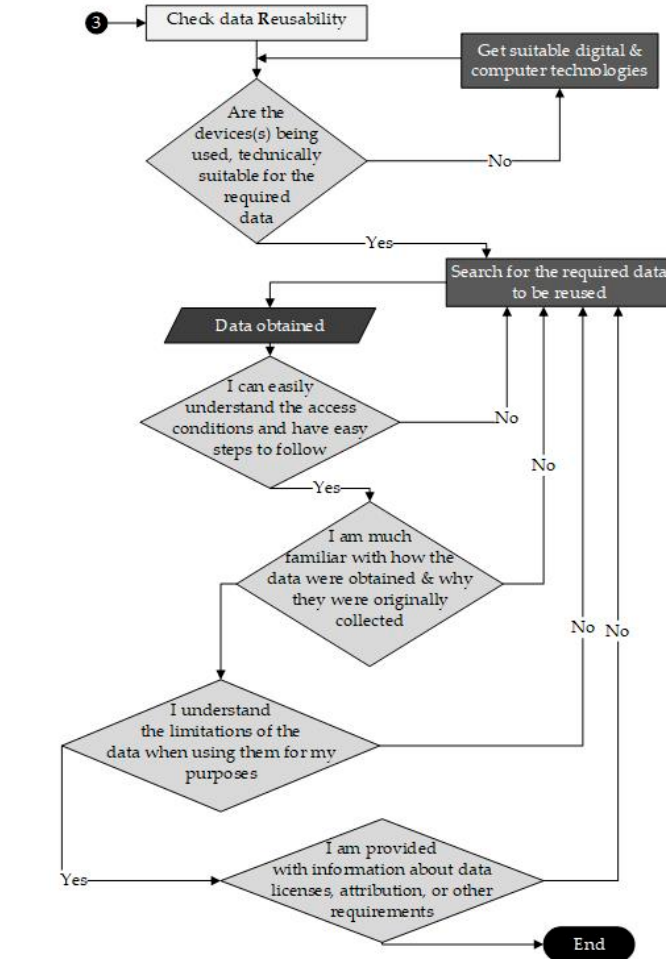
Figure 4. FAIR data process flowchart diagram in plain language.